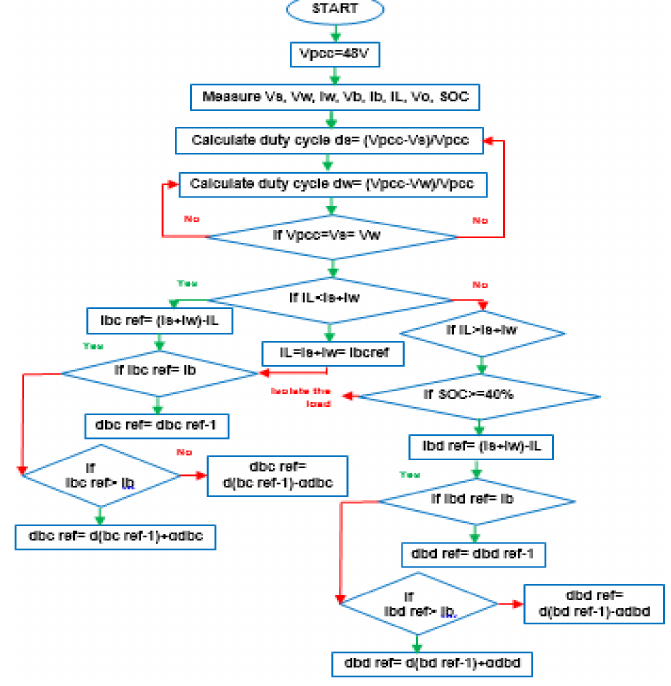
Figure 7. Detailed logic of proposed embedded-based